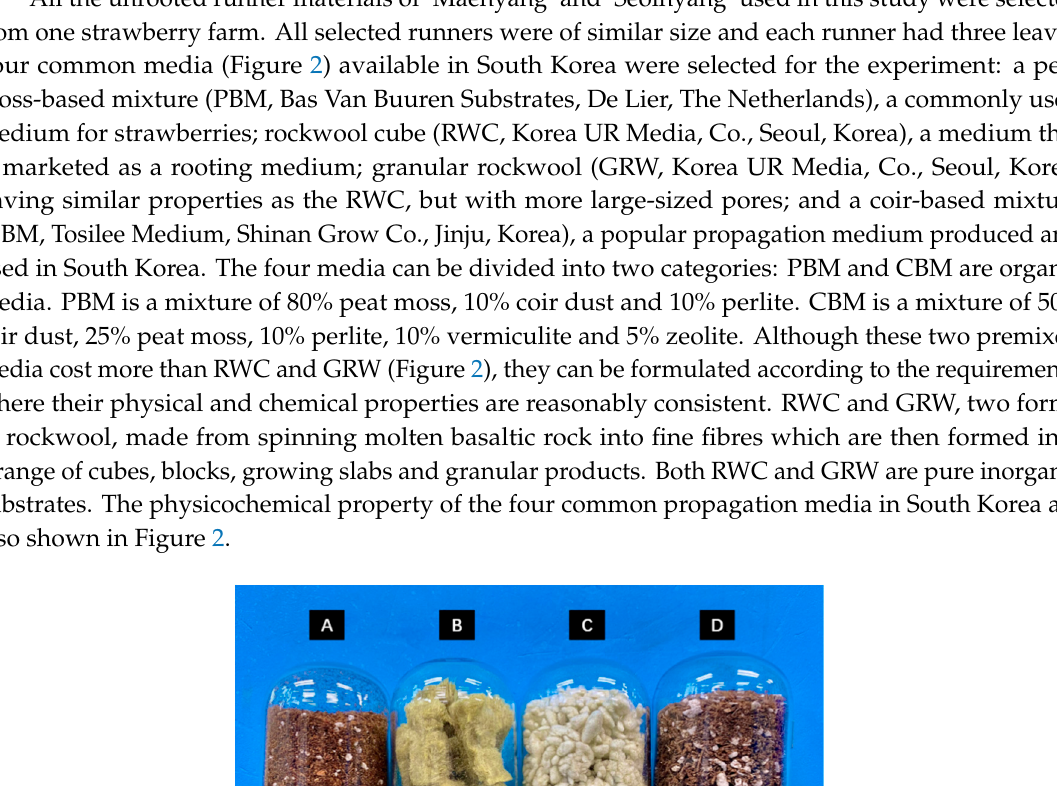
Figure 1. The temperature, relative humidity and solar radiation in the glasshouse during the experiment duration (14–27 September 2018).